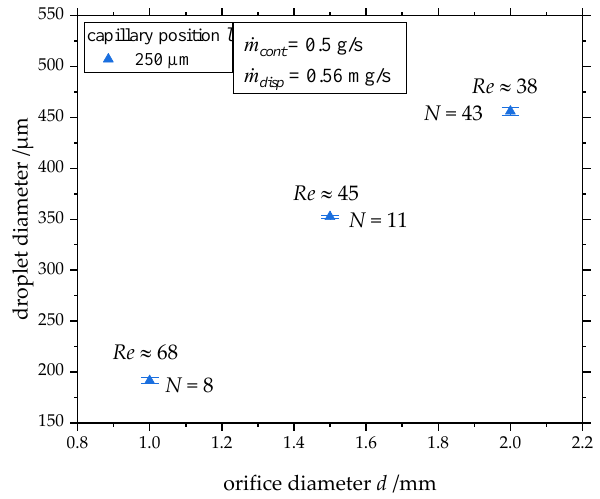
Figure 5. Influence of the orifice diameter on the droplet diameter. The Reynolds Number Re in the orifice is given at the measurement points. N represents the number of droplets that were found in the set of 100 images.